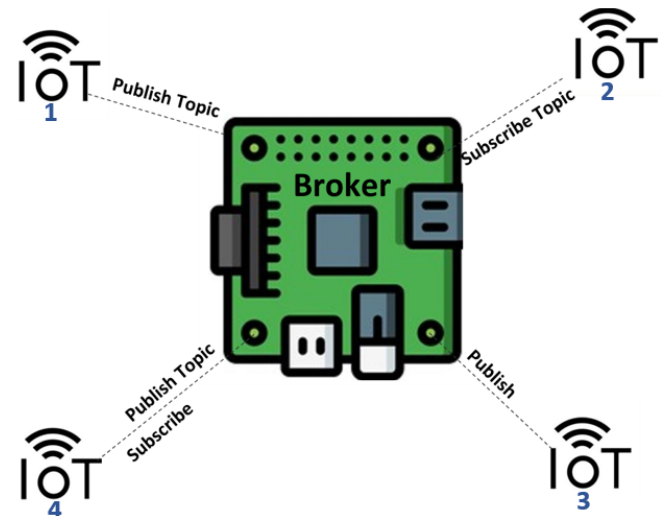
Figure 1. IoT communication via MQTT